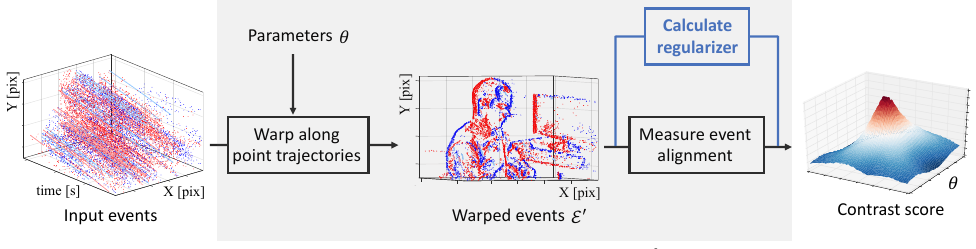
Figure 2. Proposed modification of the contrast maximization (CMax) framework in [12,13] to also account for the degree of regularity (collapsing behavior) of the warp. Events are colored in red/blue according to their polarity. Reprinted/adapted with permission from Ref. [13], 2019, Gallego et